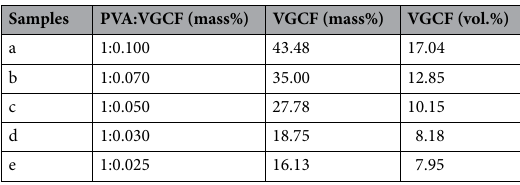
Table 1. Fabrication conditions of CNF sheets.